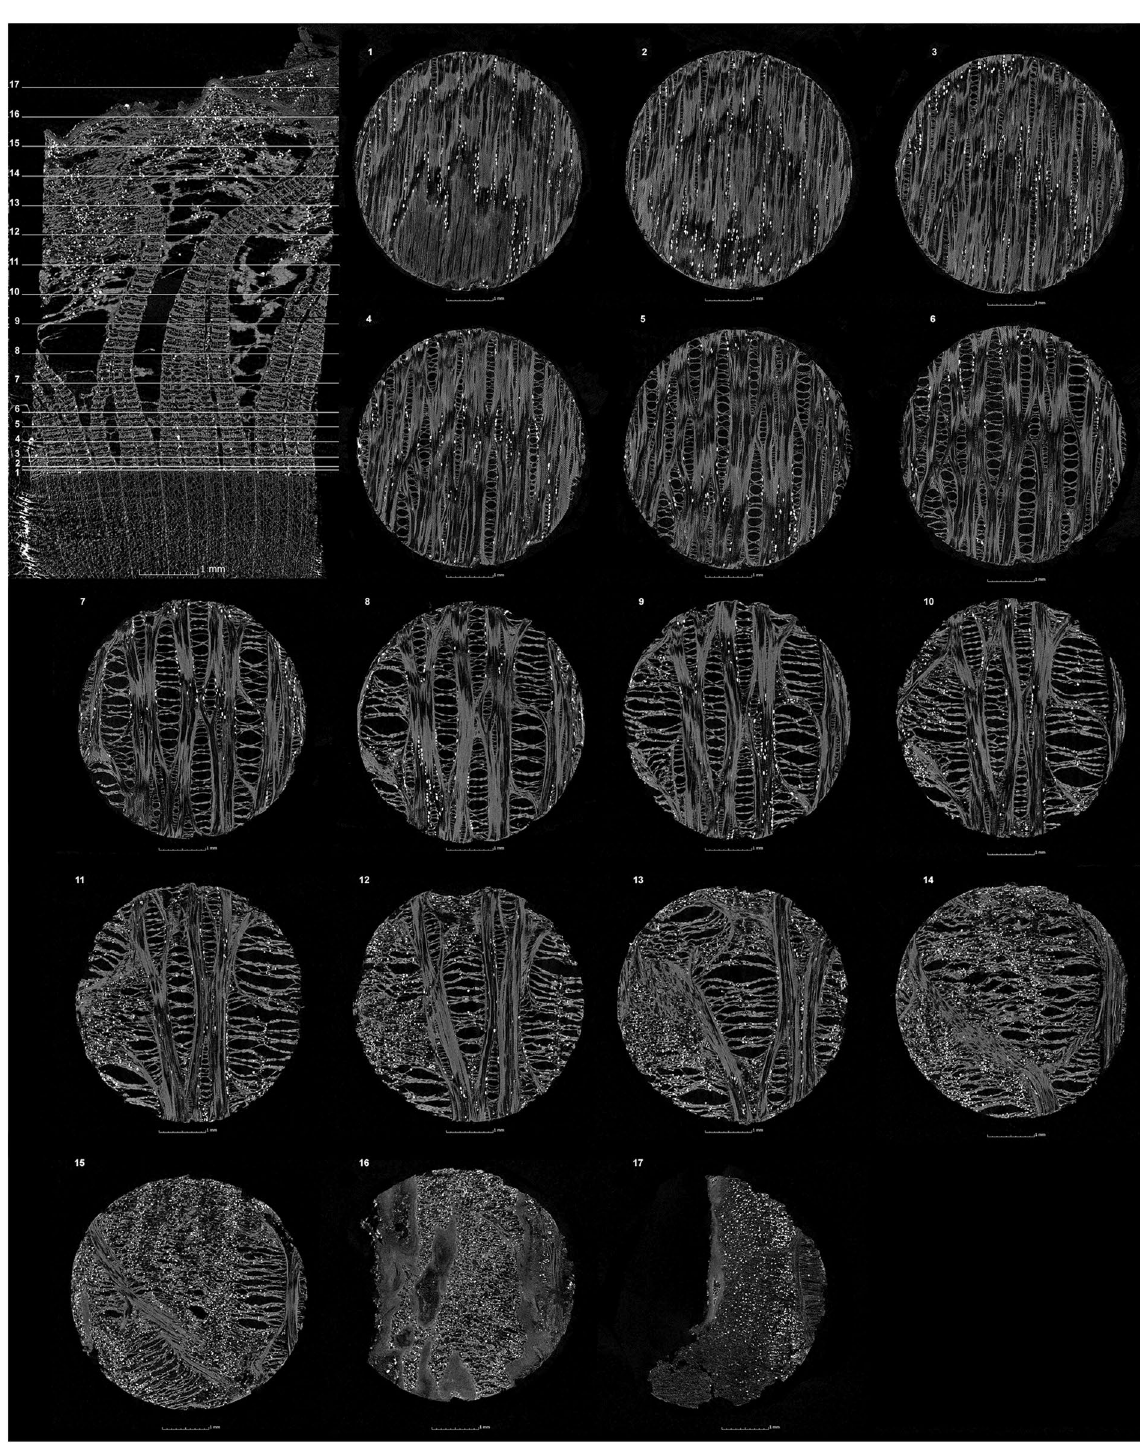
Figure 5. µCT transversal (upper left) and tangential sections of lime (sample 1). The 17 tangential sections are presented with their position on the transversal